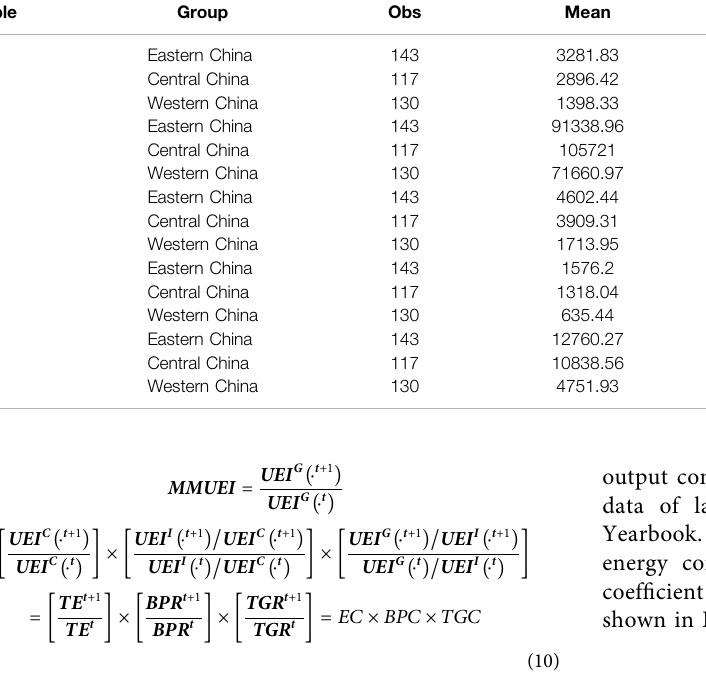
TABLE 2 | Statistics summary for measuring thermal power generation ef fi ciency.